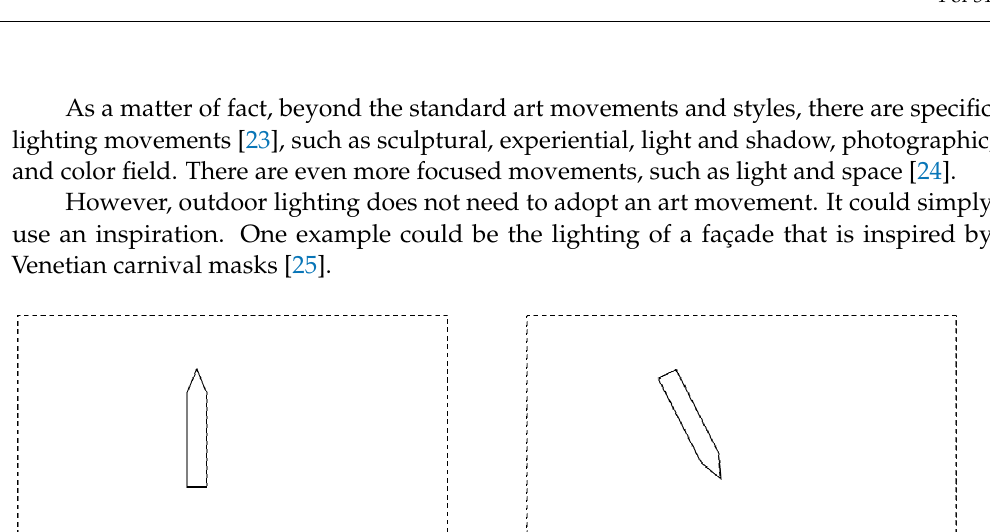
Figure 2. Mathieu’s diagram for classifying artists [19].